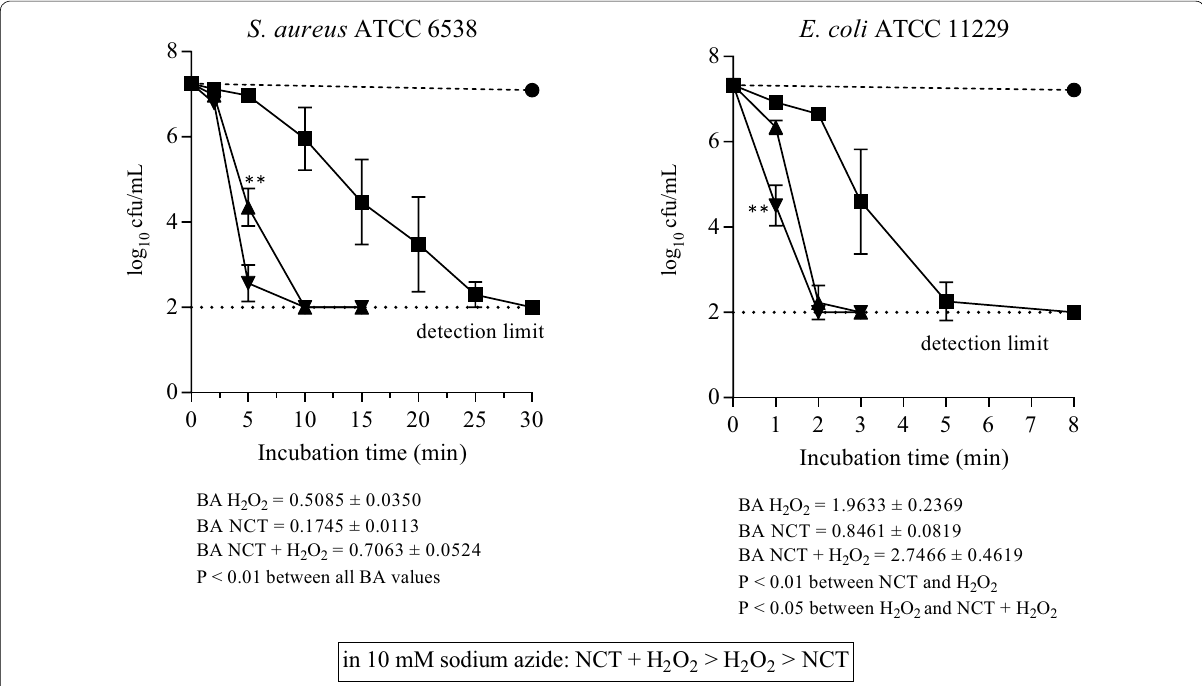
Fig. 5 Bactericidal activity of 1% NCT ( filled square ), 1% H 2 O 2 ( filled triangle ), and 1% NCT plus 1% H 2 O 2 ( inverted triangle ) at pH 7.1 and 37 °C in the presence of 10 mM sodium azide (NaN 3 ). Control in phosphate buffer plus 10 mM NaN 3 ( filled circle ). Mean values aureus ) independent experiments. ** P < 0.01 versus all other values. BA values calculated as in Fig.